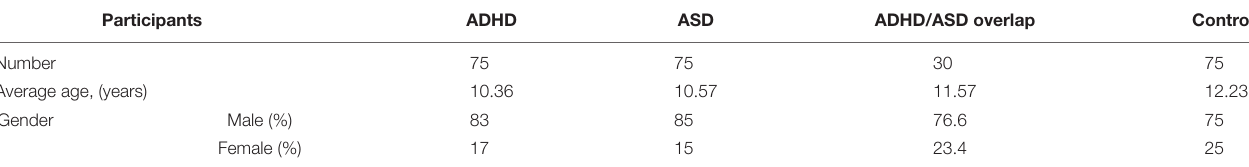
FIGURE 2 | Gel Electrophoresis pattern about DRD 1-B SNP ( rs4532 ). (A) Electrophoretic gel of 14 patients DRD 1-B amplicons (187 bp). (B) Bpu 10I enzyme digestion pattern on the same 14 patients PCR amplicons. Restriction site is on T allele. Single 187-bp electrophoresis band denotes a C/C homozygous genotype; 116-bp and 71-bp banding pattern is for a T/T homozygous genotype; the presence of three bands of 187-bp, 116-bp and 71-bp is for C/T heterozygous genotype. (C) Molecular length (bp) of restriction fragments derived from rs4532 digestion by Bpu 10I. M, DNA Molecular Weight Marker (Precision Molecular Mass Ruler, Bio-Rad Laboratories, Inc.); U, undigested PCR amplicon (187 bp). TABLE 2 | Demographic features of the study